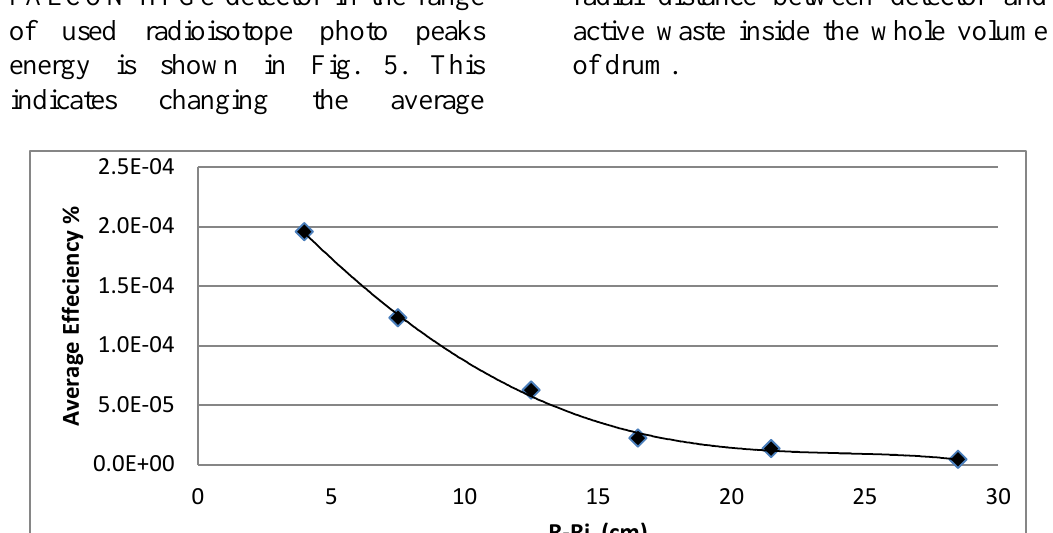
Fig. 5: Changing the average efficiency of specified energy relative to whole volume of drum in polynomial fitting order 4.